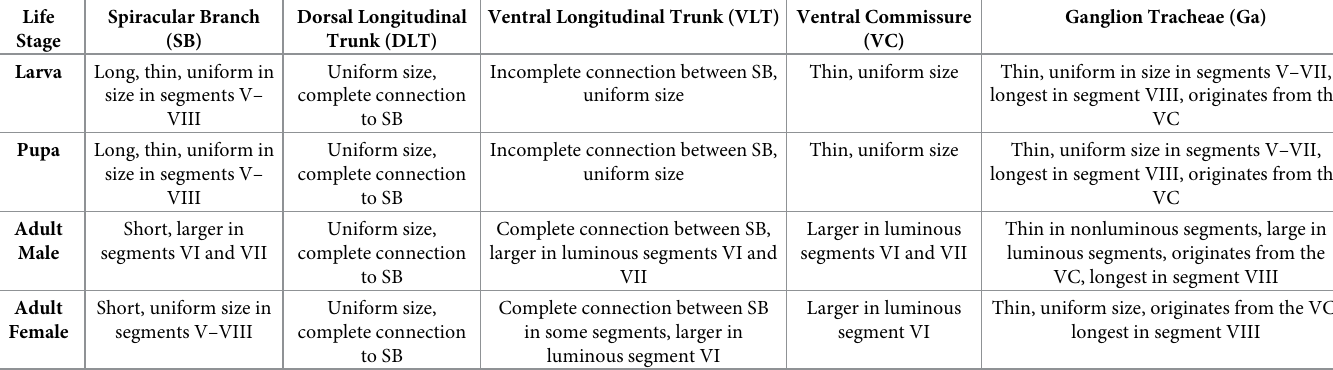
Table 2. Comparisons of the major trunks, branches, and commissures of the abdominal tracheal system in Photinus pyralis